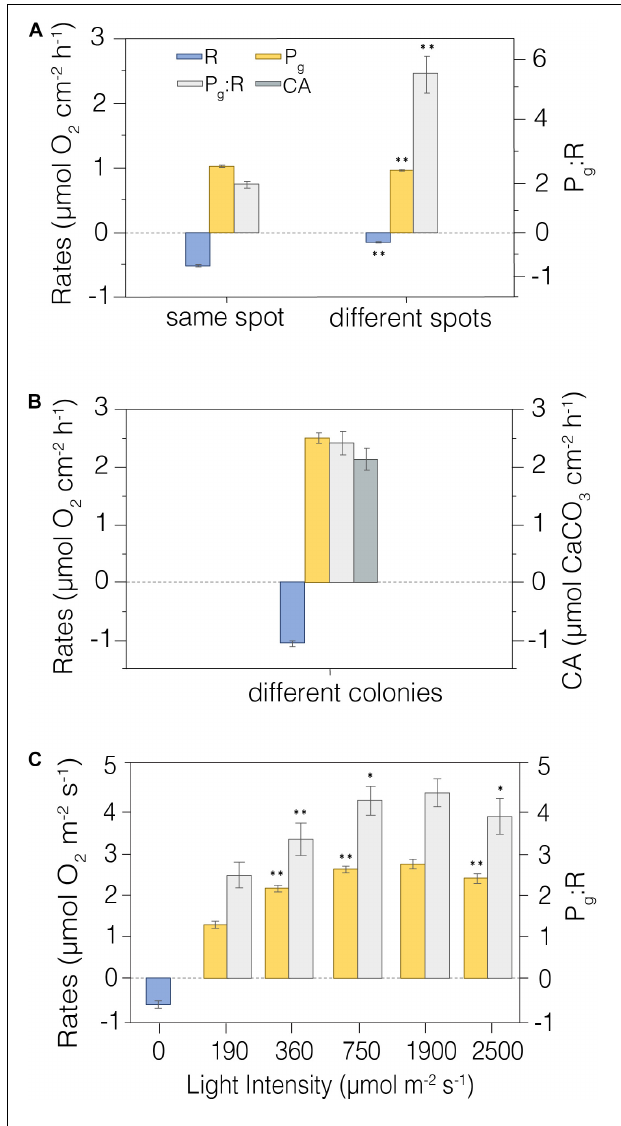
FIGURE 6 | Metabolic rates measured in situ . (A) Repeated CISME measurements taken from the same precise location on a coral surface relative to repeated measurements taken from independent locations on a single Cyphastrea sp. colony ( n = 4). (B) CISME measurements from Platygyra spp. colonies in the same dive site ( n = 6). (C) Photosynthesis and respiration rates as a function of stepped increasing simulated PAR in the CISME chamber ( n = 5); the measurements were made on a colony experiencing in situ incident radiation of ∼ 400 µ mol m - 2 s - 1 . Average and standard error shown. Average and standard error shown. **indicates significative differences p < 0.01; *Indicates significative differences p < 0.05. Legend is shown in the first